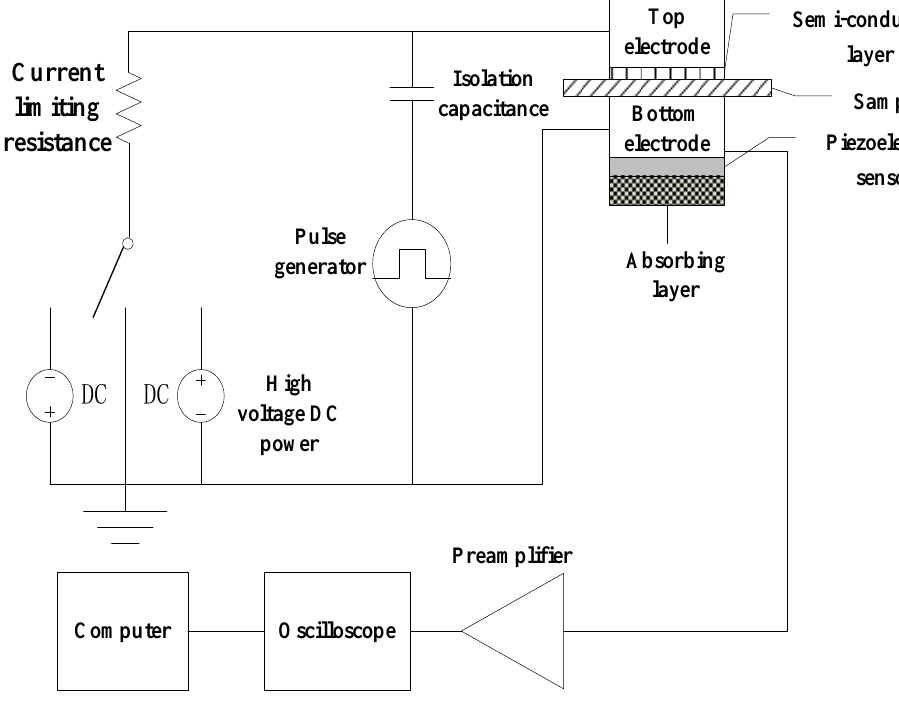
Figure 3. Test system of pulsed electro-acoustic